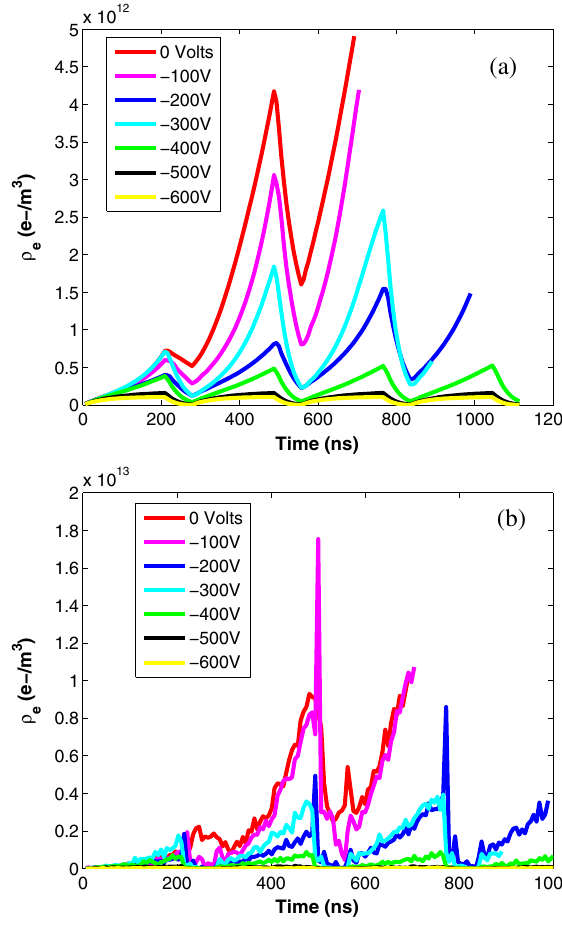
FIG. 18. Simulated buildup of the EC at the center of a wiggler pole with a negative clearing voltage applied: (a) cloud density averaged over the vacuum chamber, (b) central cloud